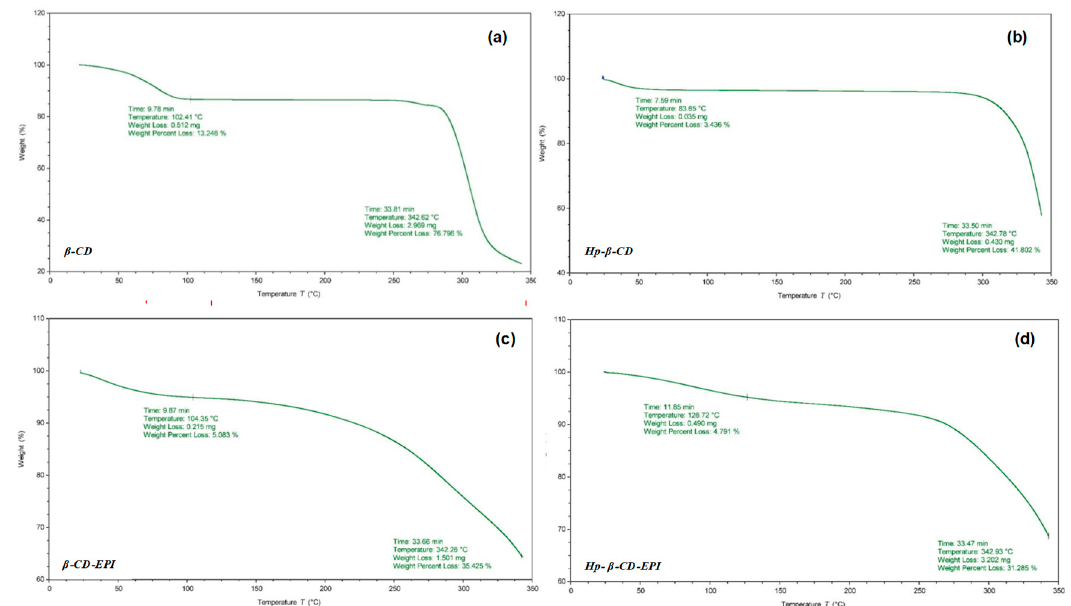
Figure 8. Thermogravimetric curves for the samples of ( a ) β -CD, ( b ) HP- β -CD, ( c ) β -CD-EPI, and ( d ) HP- β -CD-EPI polymers.